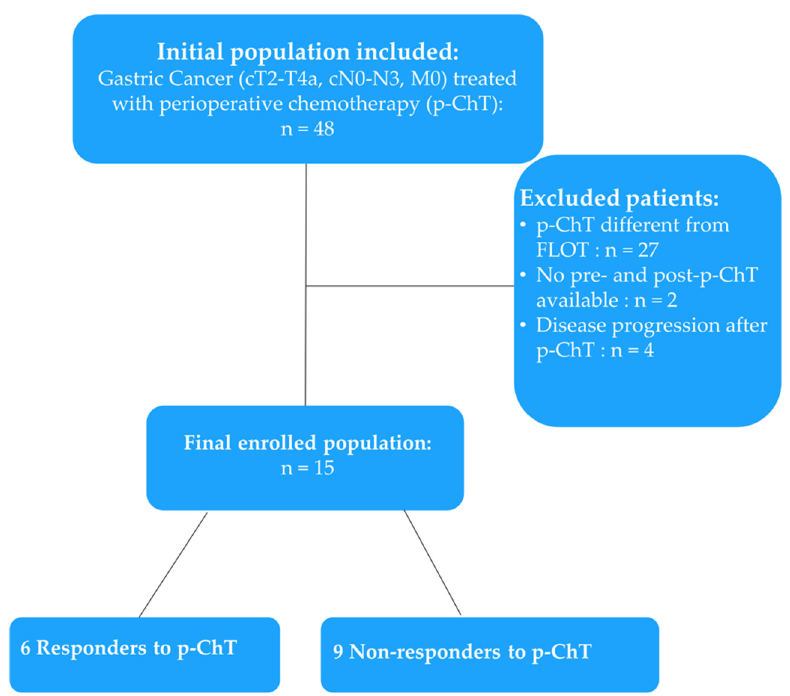
Figure 2. Enrollment population flowchart with inclusion and exclusion criteria and the final enrolled population.